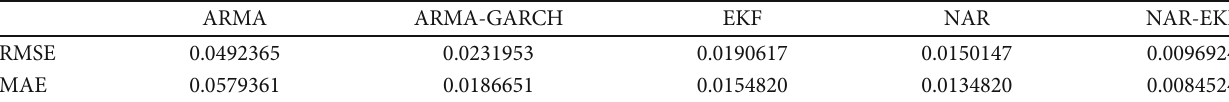
Table 2: Error comparison.